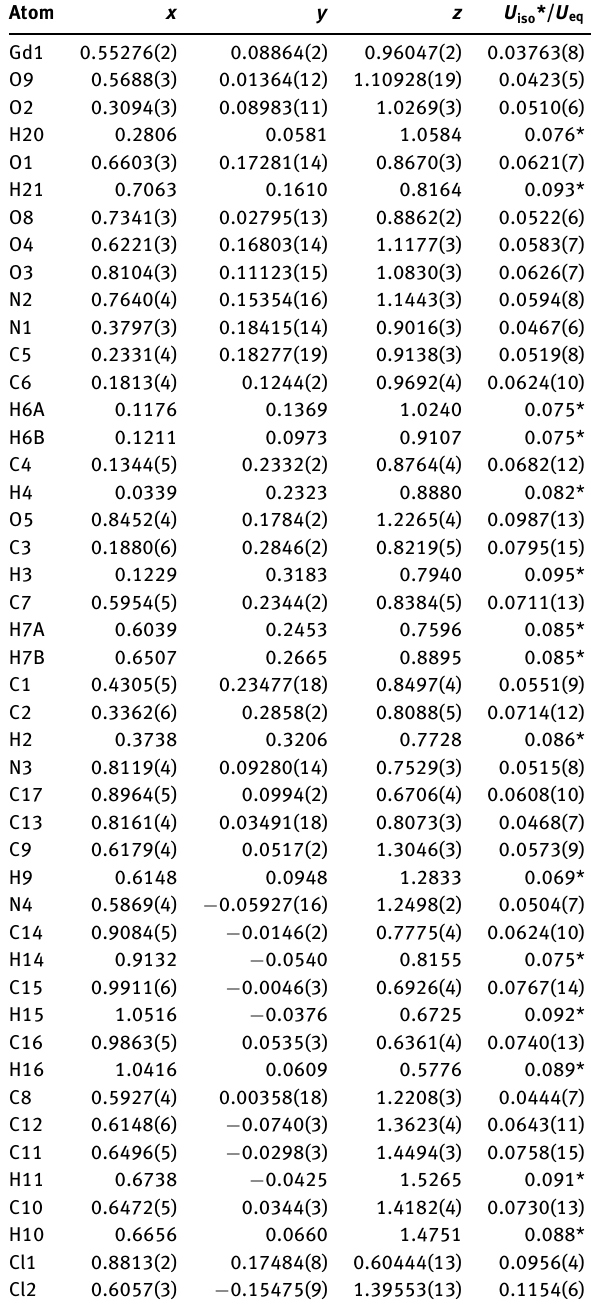
Table 2: Fractional atomic coordinates and isotropic or equivalent isotropic displacement parameters (Å 2 ).